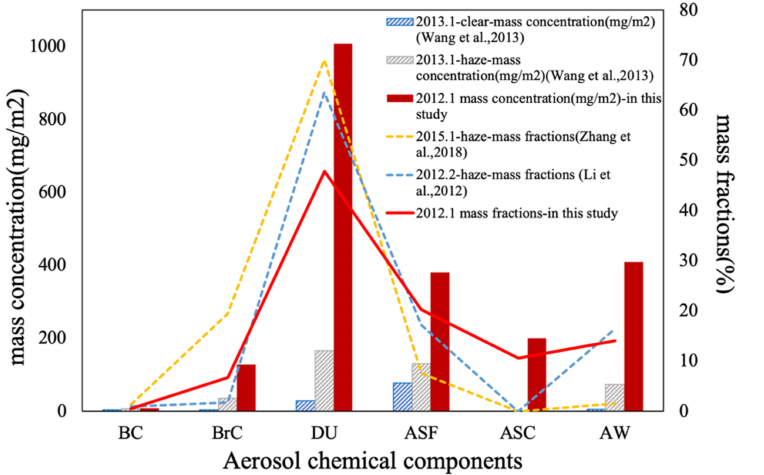
Figure 9. Comparison of aerosol component values reported in the literature and results of the present study for January 2012 in Beijing. The red line represents the mass fractions in this study, the yellow dash line represents the haze mass fractions of Zhang et al. [16], the blue dash line represents the haze mass fractions of Li et al. [11]. The red bar represents the mass concentration in this study, the gray bar represents the haze mass concentration of Wang et al. [56], the blue bar represents the clear mass concentration of Wang et al. [56]. Adapted with permission from ref. [11,16,56], Copyright 2013 Atmospheric Chemistry and Physics; 2018 Atmospheric Environment; 2013 Journal of Geophysical